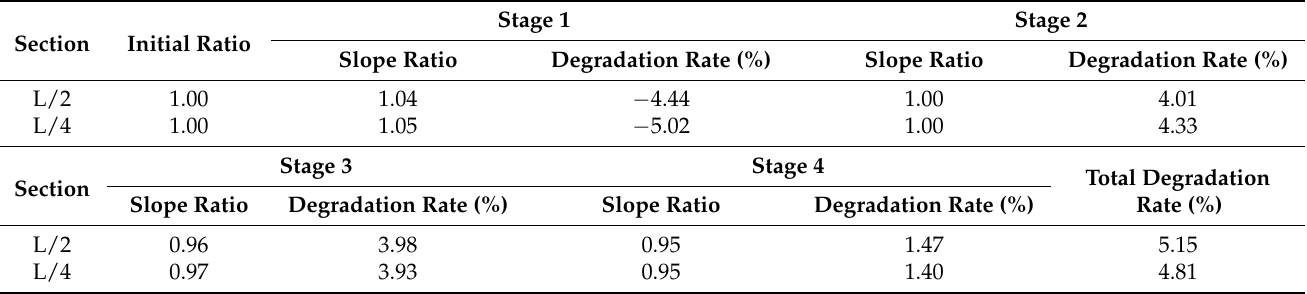
Figure 8. Slope ratio curve. Table 3. Slope